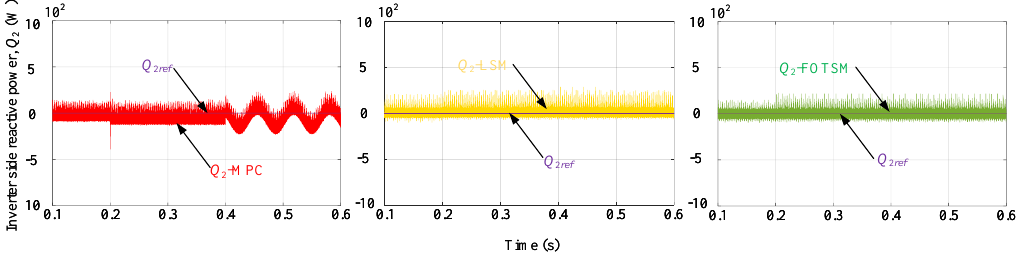
Figure 12. The load grid reactive power responses under the MPC, the LSM and the